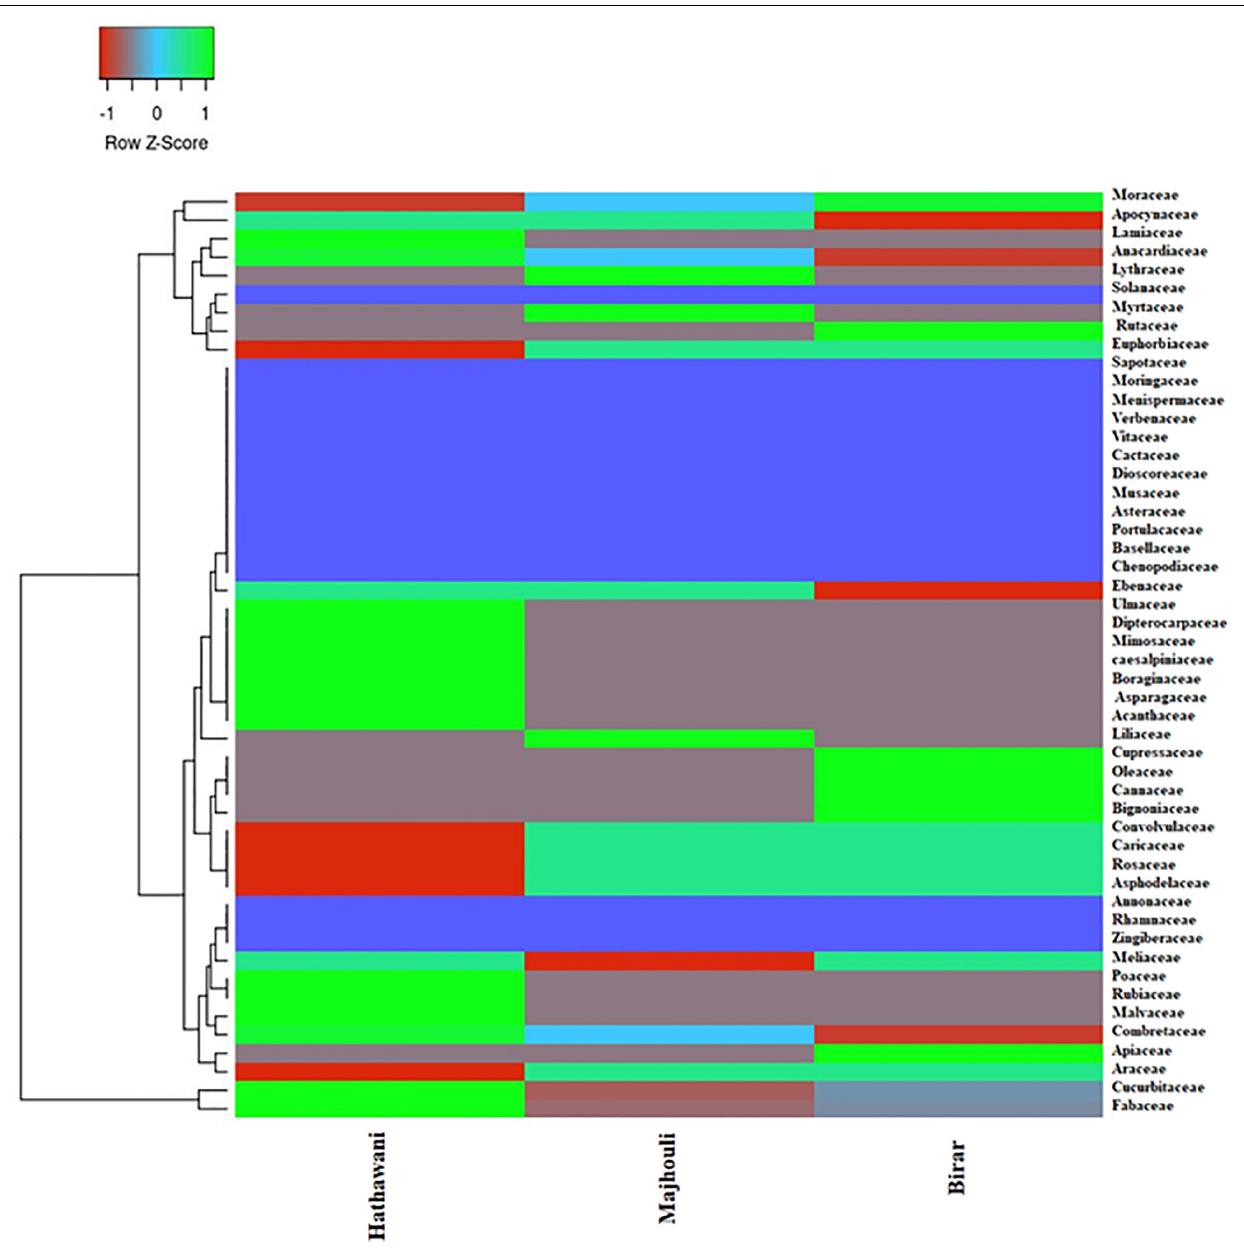
FIGURE 2 | Heat map clustering showing the distribution of species individual under various families along different disturbances – low (Hathawani), Medium (Majhouli), and High (Birar) in a dry tropical region of the Vindhyan highlands, India. The extent of individual species is shown from green to red color on the basis of z